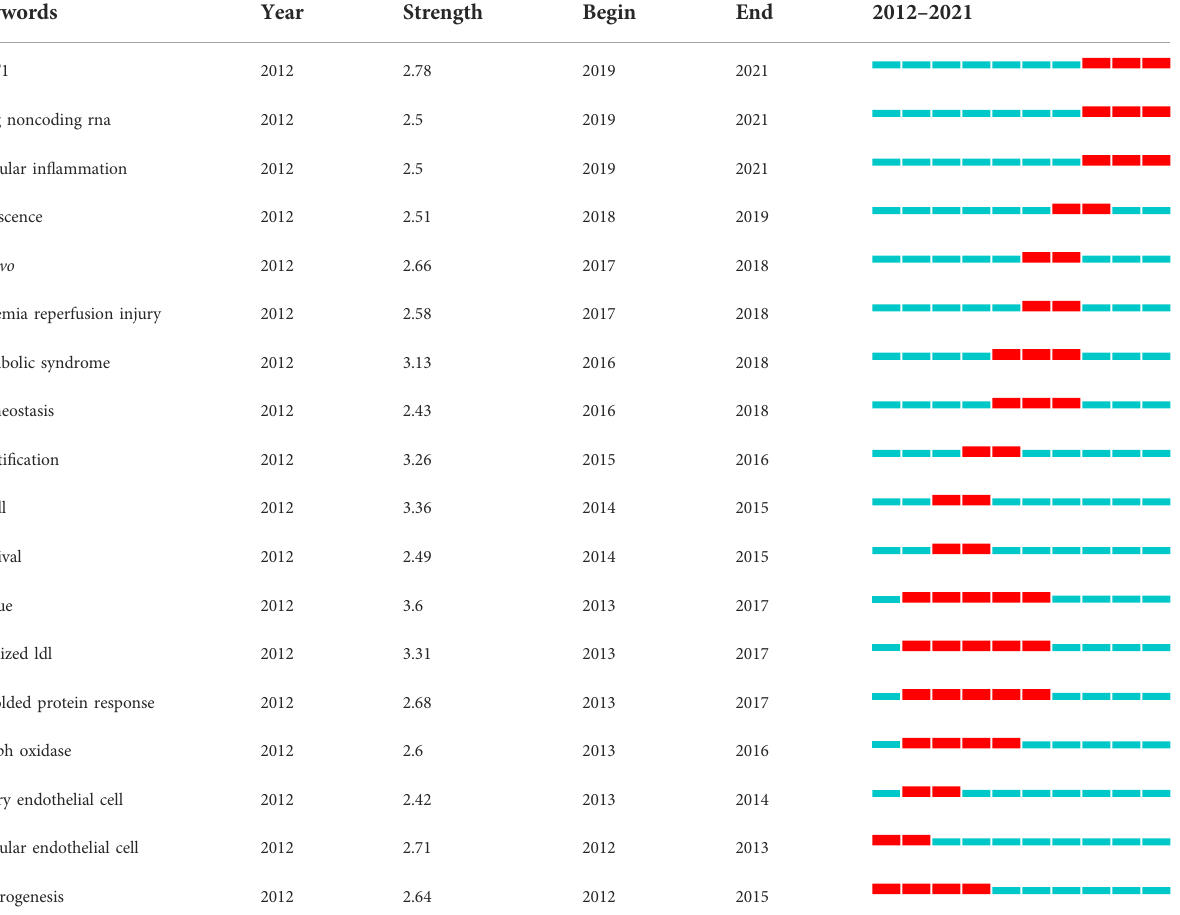
TABLE 7 Top 18 Keywords with the strongest citation